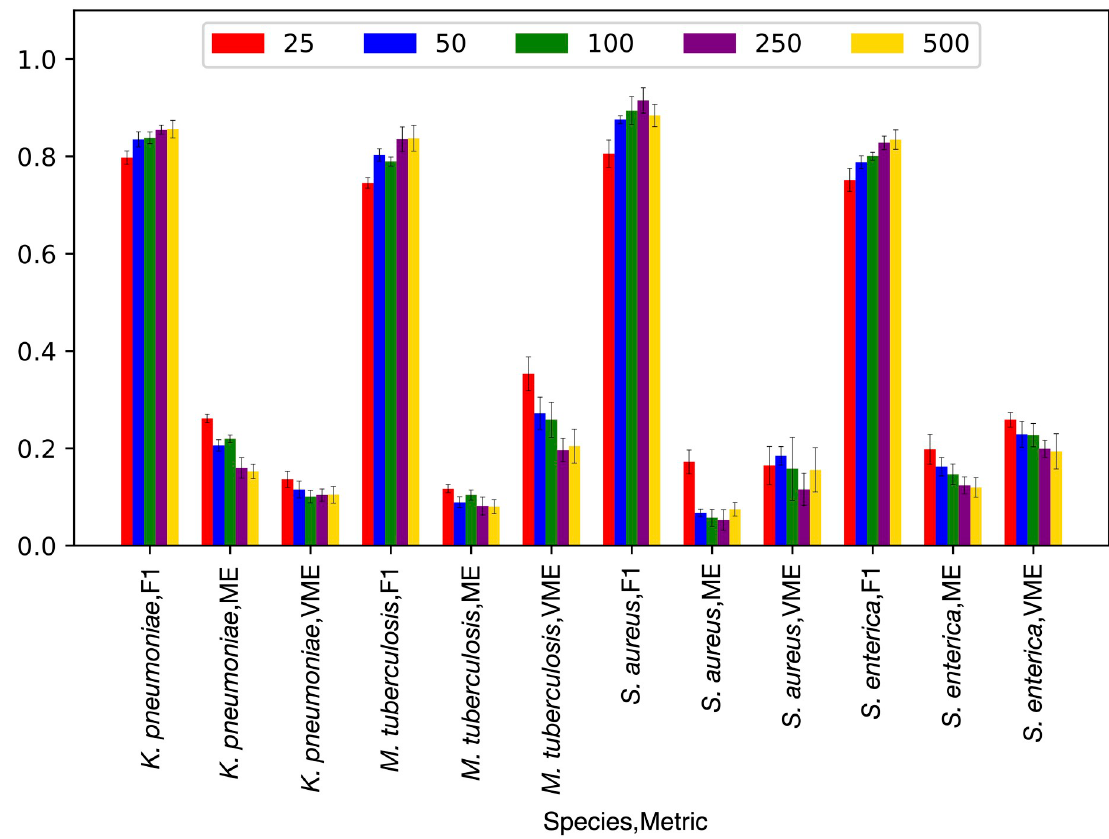
Fig 1. F1 scores, major error (ME), and very major error (VME) rates for AMR phenotype classifiers built from core gene sets. Randomly selected core gene sets ranging in size from 25–500 genes are shown. Error bars depict 95% confidence